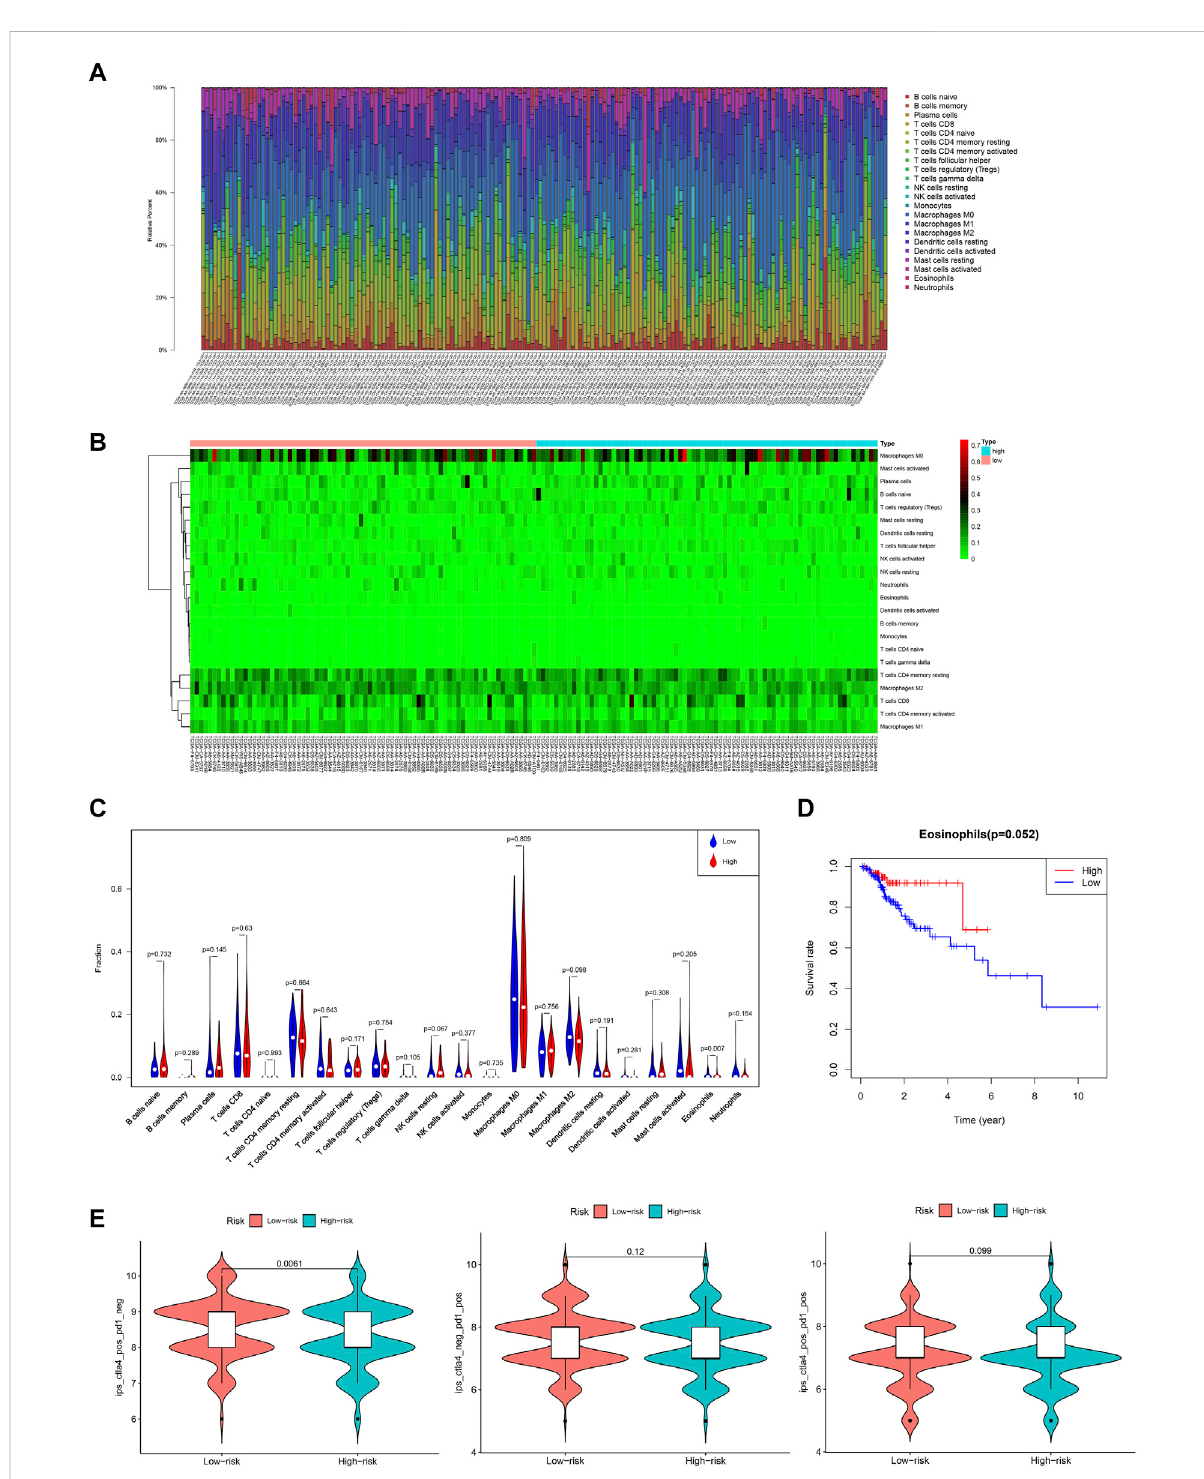
FIGURE 7 Overview of the in fi ltrating immune cells in CRC. (A) Bar plot showing the proportion of the 22 types of immune cells. (B) Heat map of the immune cells proportion betweenthe high- and low-risk groups. (C) Comparison of each immunecell type inthe two risk groups. (D) Kaplan-Meier estimatesofoverallsurvivalofpatientswithloworhigheosinophilsexpression. (E)